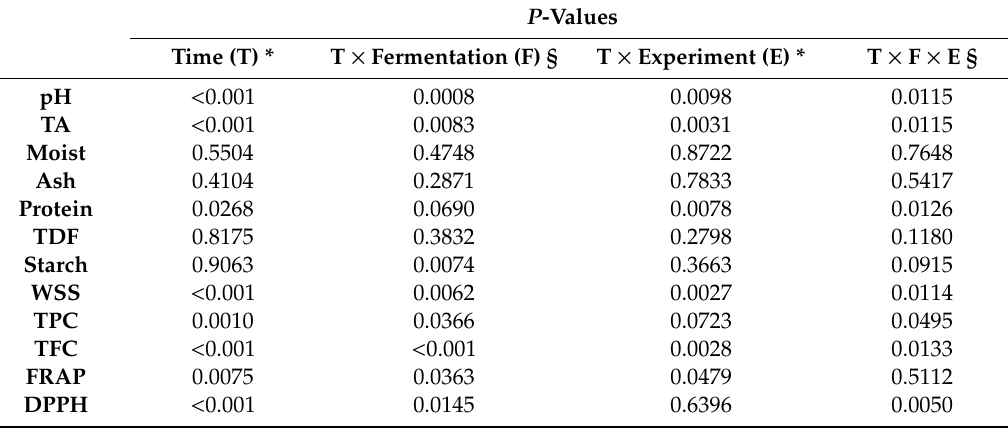
Table 5. E ff ect of time, experiment and fermentation type on chemical composition, nutritional characteristics, total phenolic content (TPC), total flavonoid content (TFC) and antioxidant activity of three hydro-alcoholic flour extracts, based on the ability to reduce ferric iron (Fe 3 + ) to ferrous iron (Fe 2 + ) (FRAP) and α -diphenyl- β -picrylhydrazyl (DPPH • ) free radical scavenging method